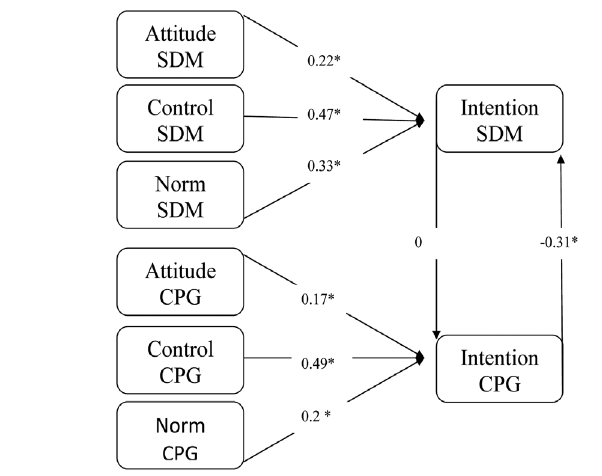
Figure 1. Standardized path analysis coefficients for control group at study entry, showing attitude, perceived behavioral control and subjective norm as predictors of physicians’ behavioral intentions to engage in SDM and to follow CPGs; and showing the influence of the intention to engage in SDM on the intention to follow CPGs and vice versa (vertical arrows).